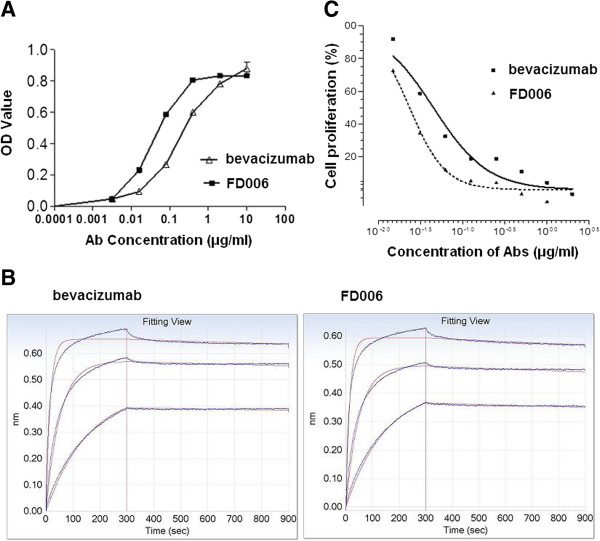
Antigen binding identification of FD006 to bind VEGF. (A) The binding activity of FD006 by ELISA; (B) Affinity detection of FD006 by binding kinetics assays; (C) The inhibitory effects of FD006 on VEGF-induced human umbilical vein endothelial cell (HUVEC) proliferation. The proliferation percentage was calculated using the formula ODsample/ODuntreated × 100 %. Data points represent the mean 6 SD of values acquired in duplicate.